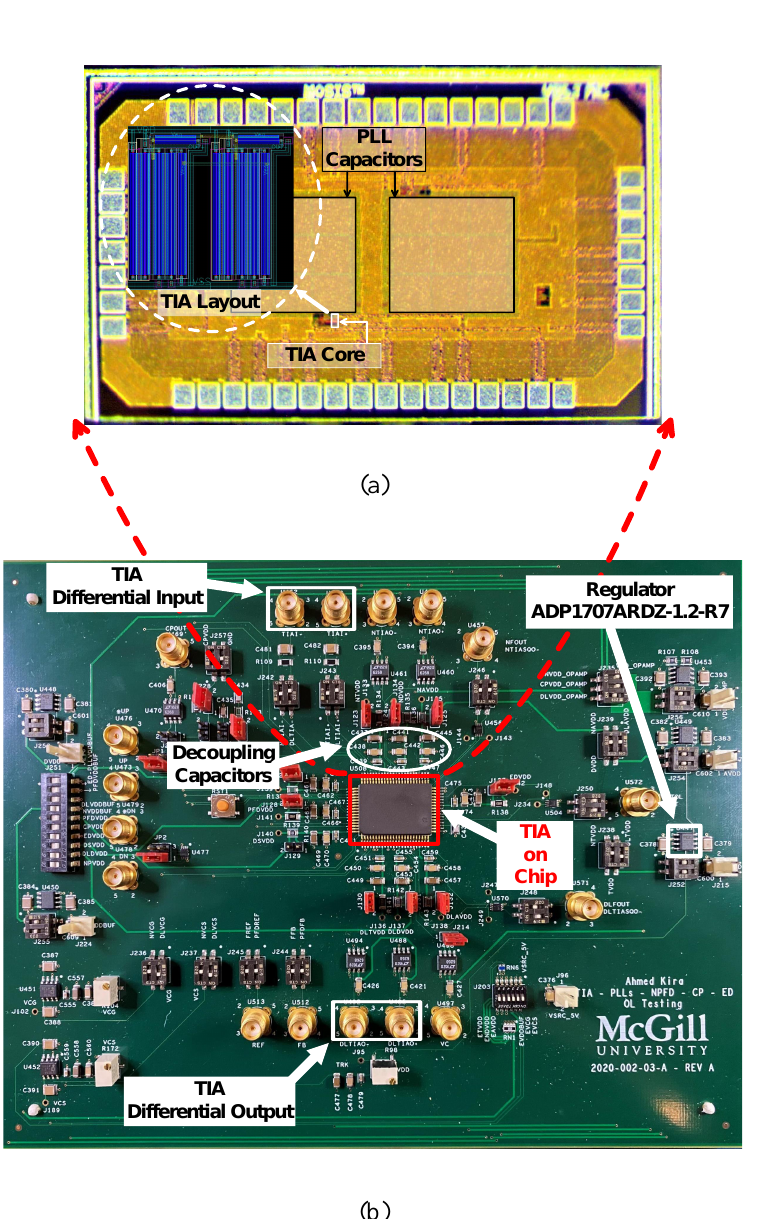
Figure 9. ( a ) Fabricated die micrograph and ( b ) photograph of the PCB used to test the TIA. The prototype CMOS die is assembled in an 80-pin ceramic quad flat pack (CQFP) package and mounted on a custom 4-layer printed circuit board (PCB), as shown in Figure 9b. The test board includes SMA connectors for the input/output signals, coupling capacitors (1 uF) at the input signals to filter out the DC component, and a voltage regulator (Analog Devices ADP1707ARDZ-1.2-R7) to regulate the input supply from a DC power supply source (Agilent E3646A). In addition, all power nets are decoupled with a network of decoupling capacitors (10 nF, 100 nF, 1 µ F) connected in parallel and in an ascending order from the integrated circuit (IC) package lead. There are other components on the PCB—Figure 9b—that are not related to this specific TIA